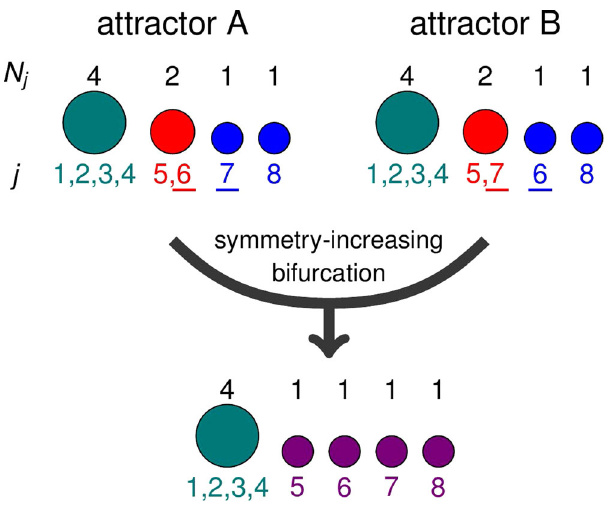
Fig. 4 Schematic of a symmetry-increasing bifurcation destroying clusters. Here, two equivalent variants of a 4 − 2 − 1 − 1 solution collide. The increase in attractor symmetry caused by the collision implies that any two oscillators which behaved equivalently in either of the variants must also behave equivalently in the resulting solution. Because the cluster of two contains different oscillators in the two variants, this cluster is necessarily destroyed. N j denotes cluster sizes and j denotes the index of each oscillator.